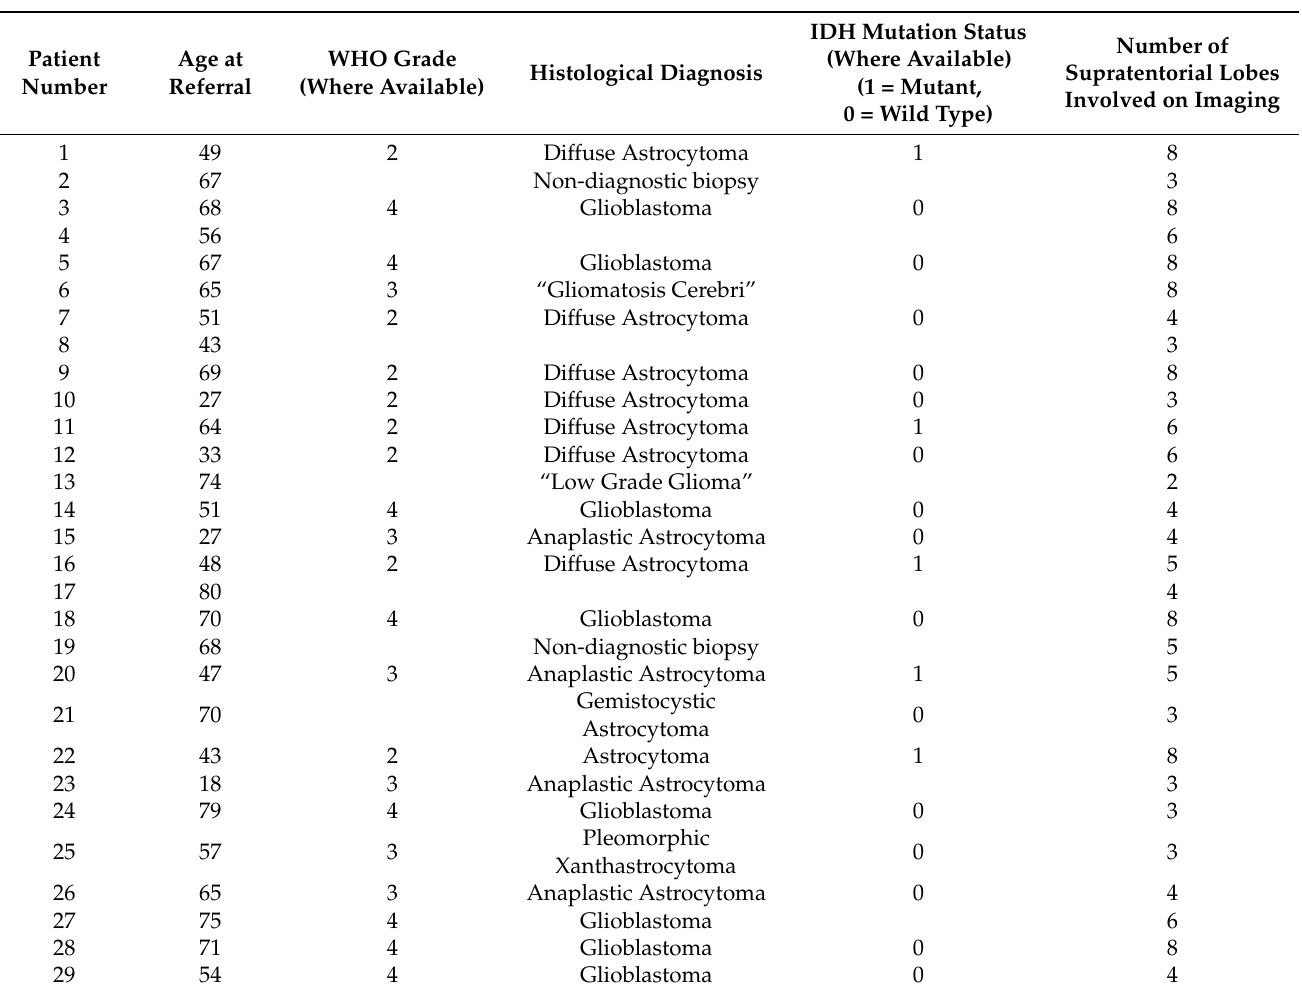
Table 3. Tumour WHO grade, histological diagnosis, IDH mutation and number of supratentorial lobes involved on imaging for individual gliomatosis